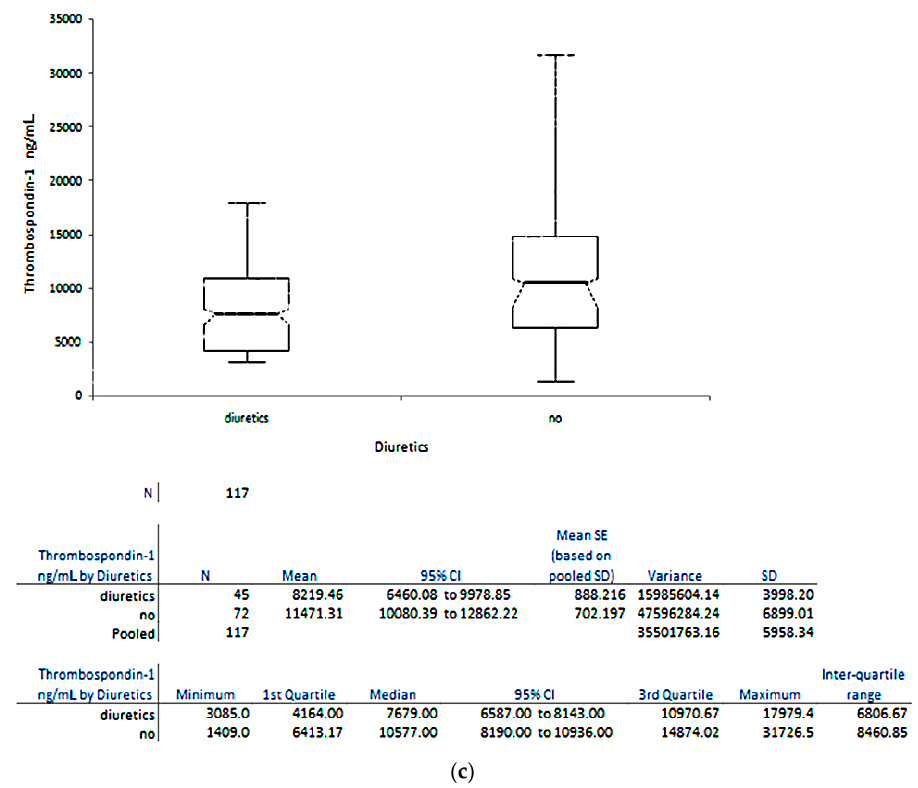
Figure 3. Variation of TSP-1 plasma levels in Group B, under different antihypertensive treatment: ( a ) beta blockers, ( b ) calcium channel blockers, and ( c ) diuretics